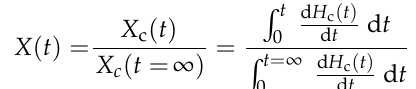
Figure 3. The equilibrium melting temperature via the Hoffman – Weeks method for the T mo of ( a ) peak I and ( b ) peak II.